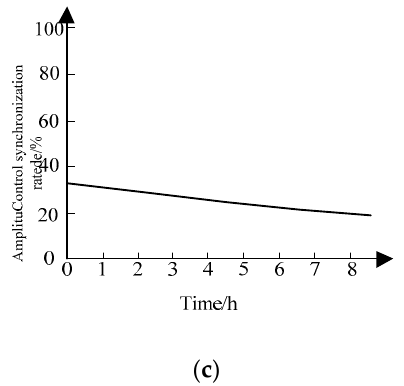
Figure 4. Comparison of the stability of different algorithms. ( a ) Synchronous control algorithm based on fuzzy neural network. ( b ) Synchronization control algorithm based on multi-factor self-tuning fuzzy control. ( c ) Synchronous control algorithm based on improved fractional order non-growth adaptive law.